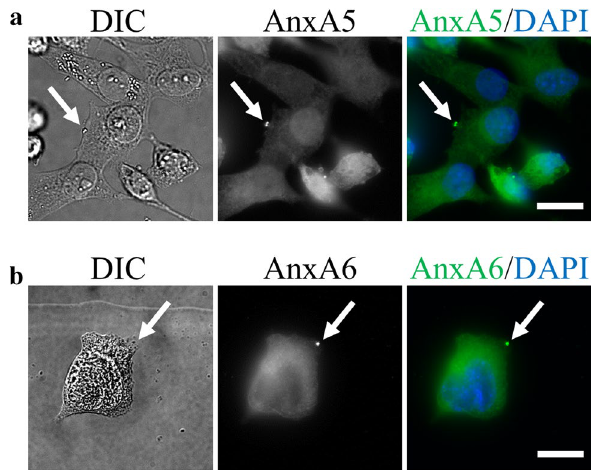
Figure 6. Subcellular localization of endogenous AnxA5 and AnxA6 in damaged MDA-MB-231. MDA-MB-231 cells were irradiated with a 110-mW infrared laser (white arrow) in DPBS + Ca 2+ , then fixed and immunostained for AnxA5 ( a ) or AnxA6 ( b ). After laser injury, MDA-MB-231 cells exhibited an accumulation of AnxA5 or AnxA6 at the disruption site. Scale bar: 20